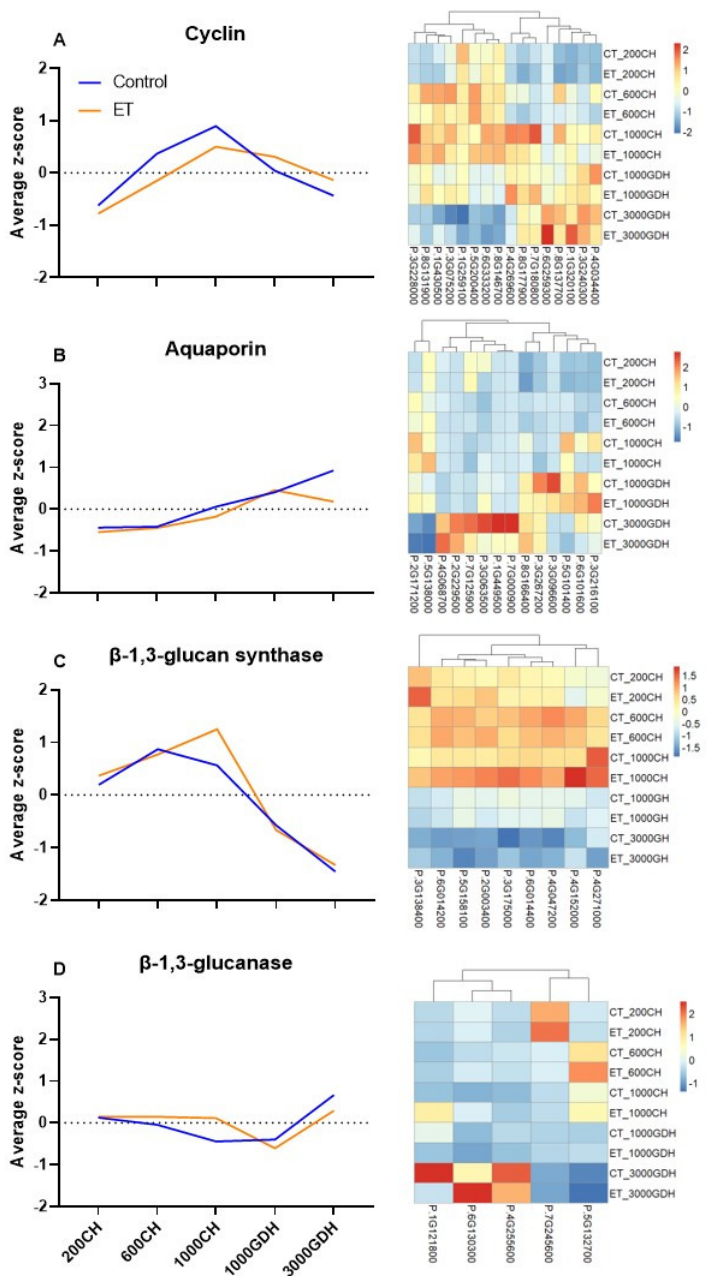
Figure 8. Expression patterns of four genes that are closely associated with cell division and inter-cellular transport. ( A − D ) mean z-score values (on the left) and heatmap (on the right) of normalized FPKM values of each gene.